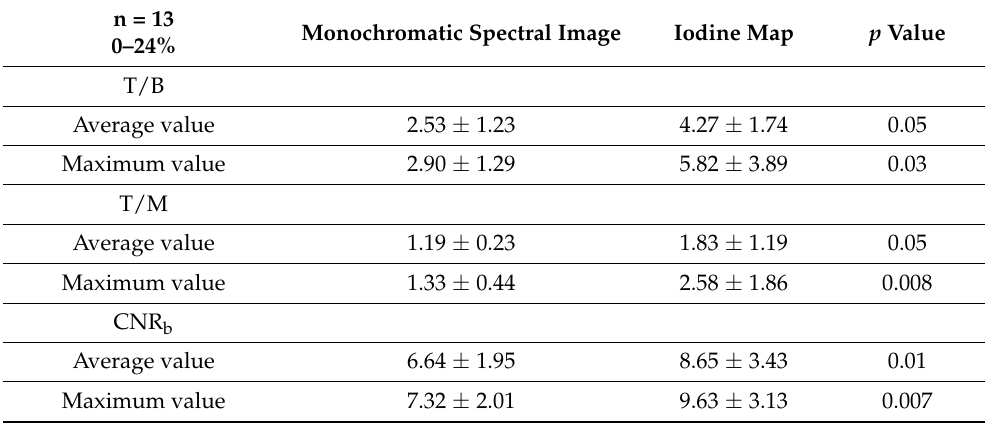
Table 3. Comparison of T/B, T/M, and CNR b obtained from the monochromatic spectral images and iodine maps for breast density of 0–24%.